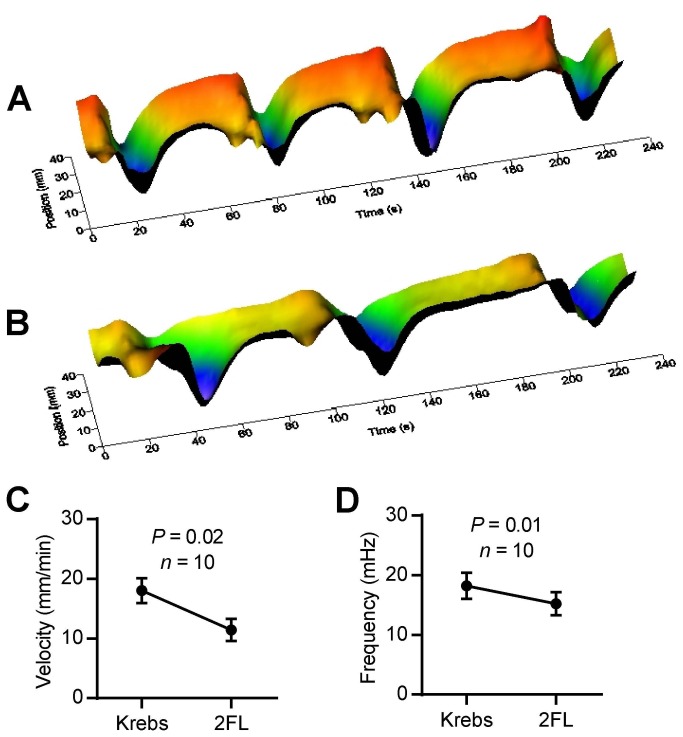
Effects of 0.5 mg/mL intraluminal 2’FL on colon motility.Heat maps derived from black/white spatio-temporal video recordings of colon motility. (A) Shows regular migrating motor complexes (MMCs) during control recording. (B) Addition of 2’FL to the lumen decreased both the slope (MMC velocity) of the valleys and MMC frequency. (C, D) Summary statistics of before and after experiments showing that 2’FL significantly reduced both MMC velocity (C) and frequency (D).